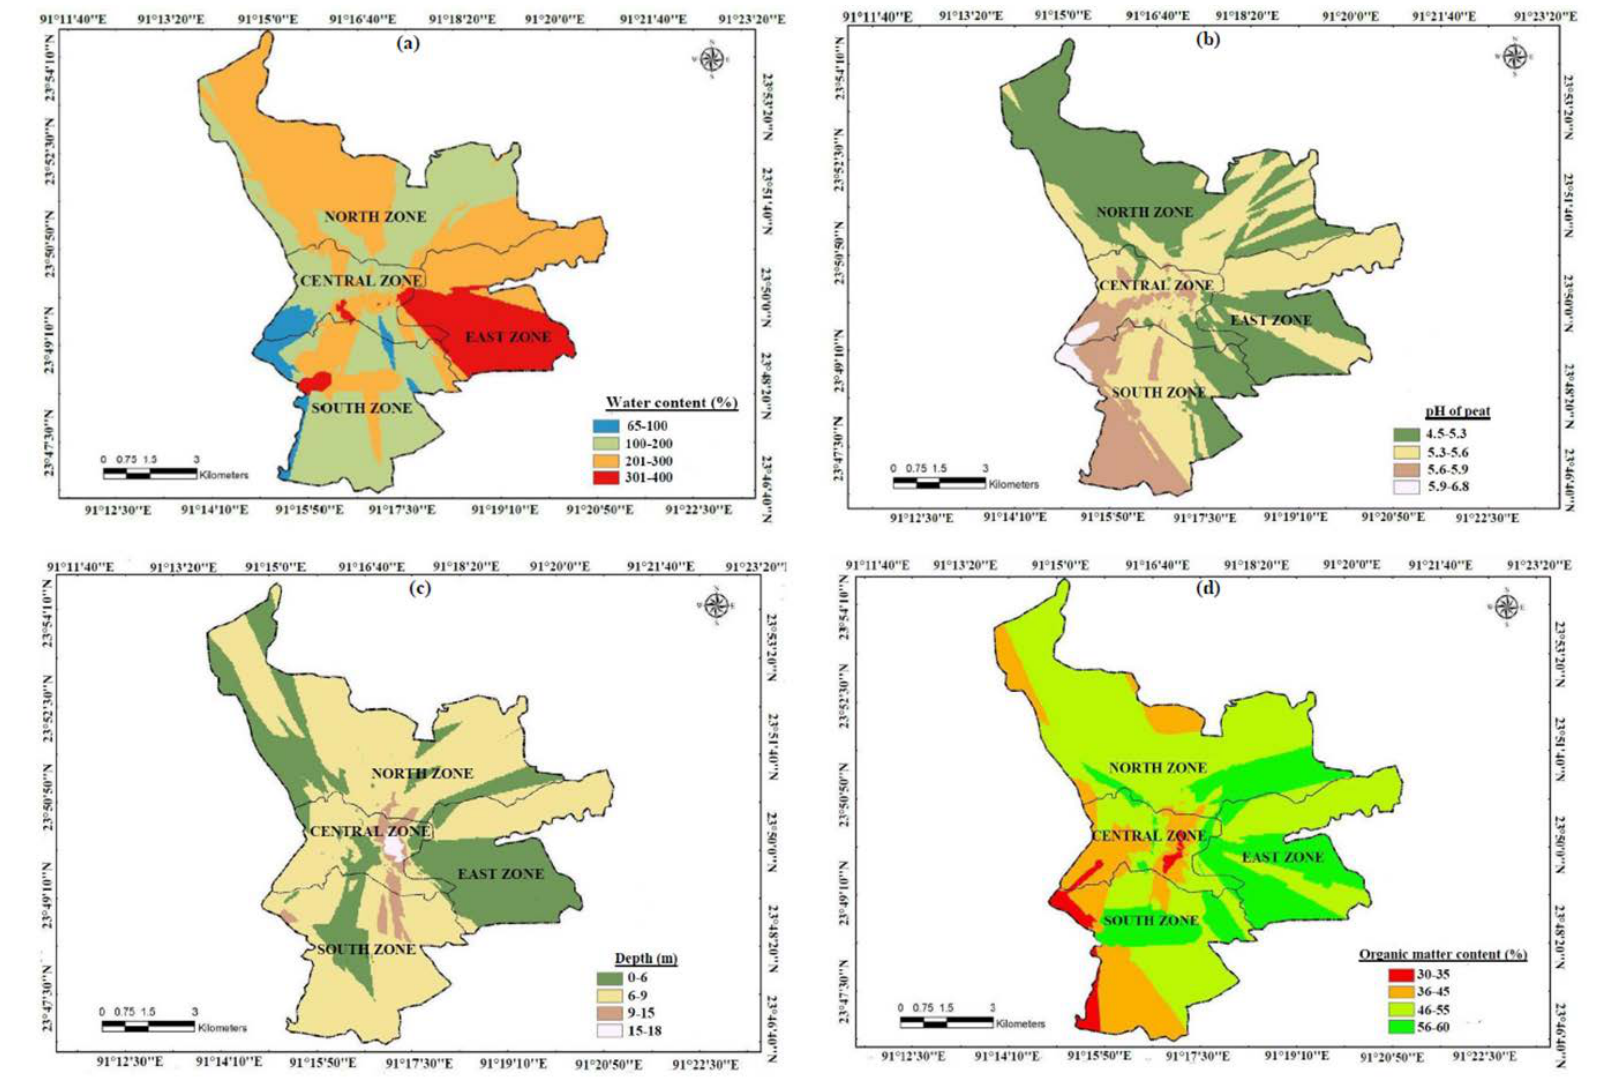
Figure 5. GIS maps presenting the spatial variation of various properties of peat:- (a) water content; (b) pH; (c) depth; and (d) organic matter